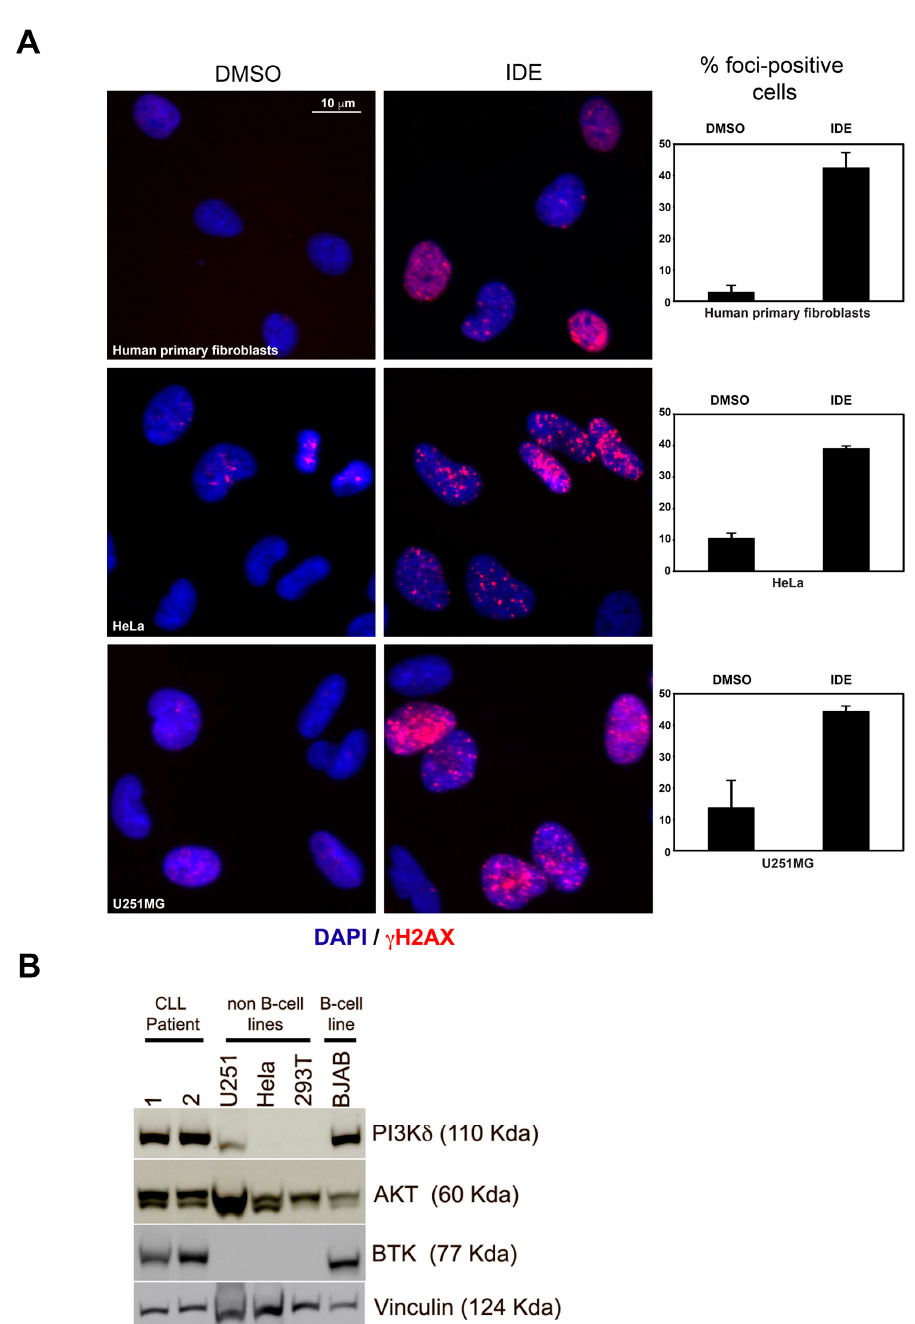
Figure 5. Induction of γ H2AX foci by idelalisib (IDE) in non-B cell lineage cell lines. ( A ) Human primary fibroblasts, HeLa and U251MG cells were treated with IDE (20 µ M, in media) for 18 h followed by immunostaining for γ H2AX and imaged via epifluorescence microscopy. In the absence of an intact B cell receptor (BCR) signaling pathway, IDE can induce phosphorylation of H2AX on ser-139. Graphs represent quantification of percentage γ H2AX foci-positive cells ( n = 100 for each treatment group, N = 3, error bars represent standard error of the mean (SEM), scale bar represents 10 µ m and corresponds to all images). ( B ) Western blot showing absence of the δ isoform of phosphatidyl-inositol 3 kinase (PI3K δ )—Bruton’s tyrosine kinase (BTK) signaling in non B-cell cell lines, compared to chronic lymphocytic leukemia (CLL) patients and B-cell cell lines.